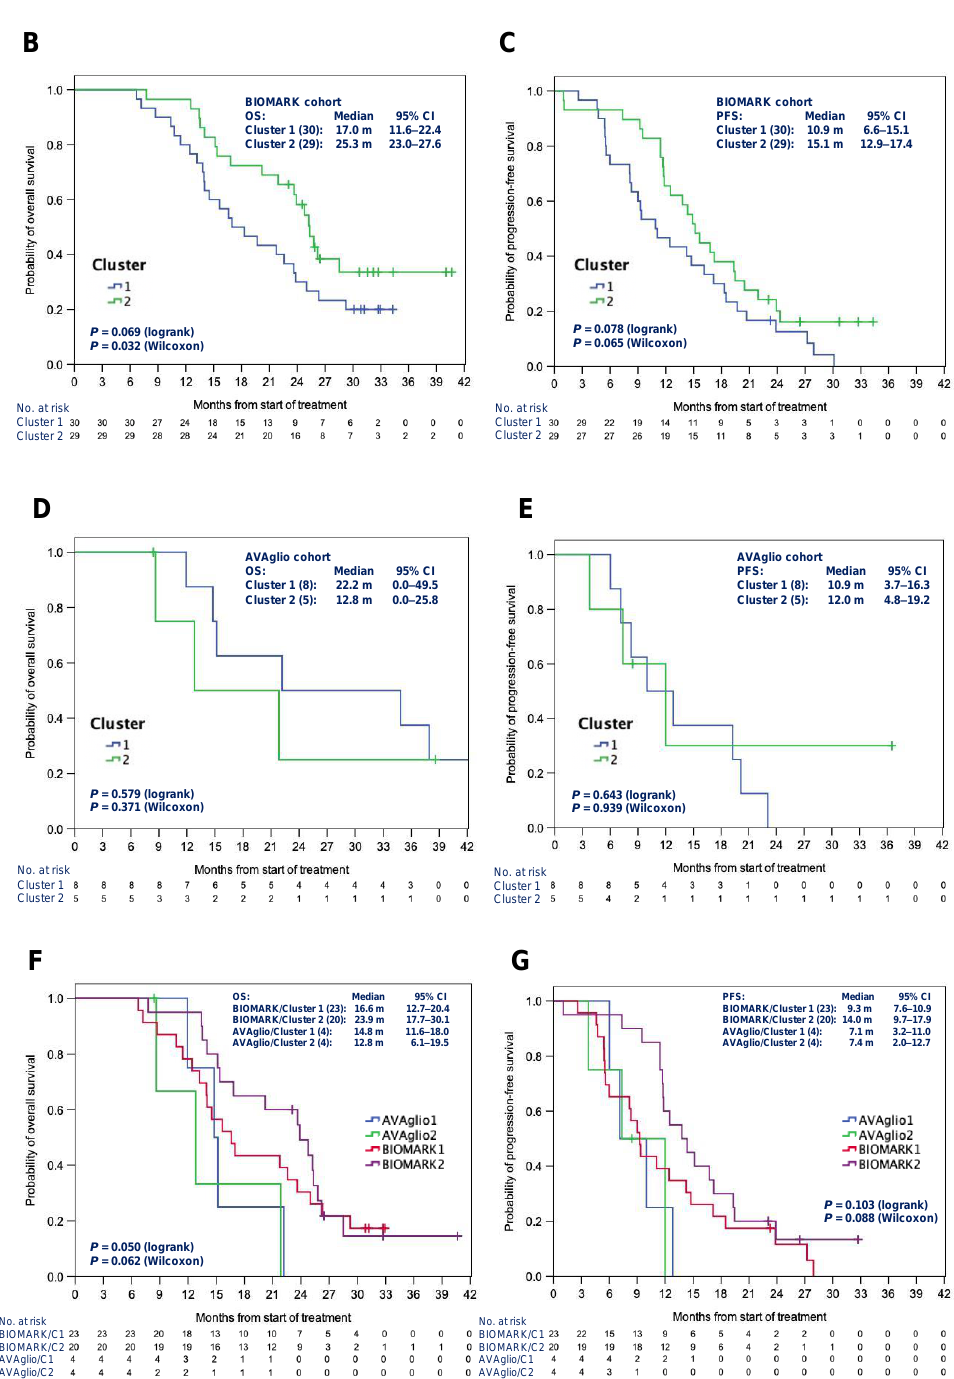
Figure 3. Heatmap of the 1000 genes that are most differentially expressed across the BIOMARK and AVAglio control cohorts ( A ). OS ( B ) and PFS ( C ) in the BIOMARK cohort and OS ( D ) and PFS ( E ) in the control cohort using the RNAseq Classifier. OS ( F ) and PFS ( G ) by Cluster in the BIOMARK and control cohorts with unmethylated MGMT